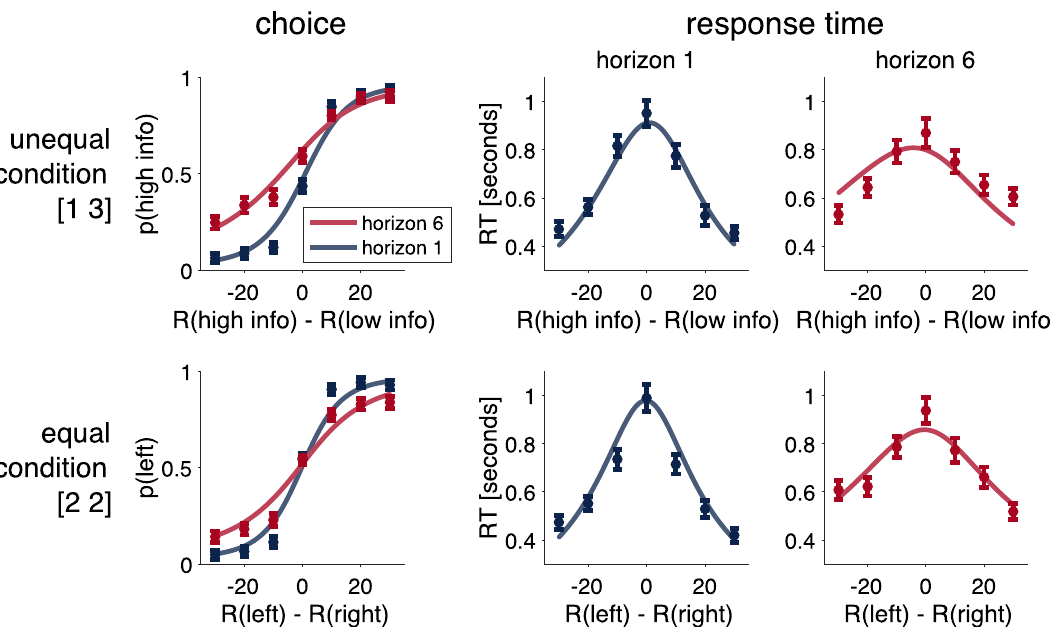
Figure 7. The drift-diffusion model (solid lines) captures the main qualitative effects of human choice and response time data (dots) in all conditions of the experiment.